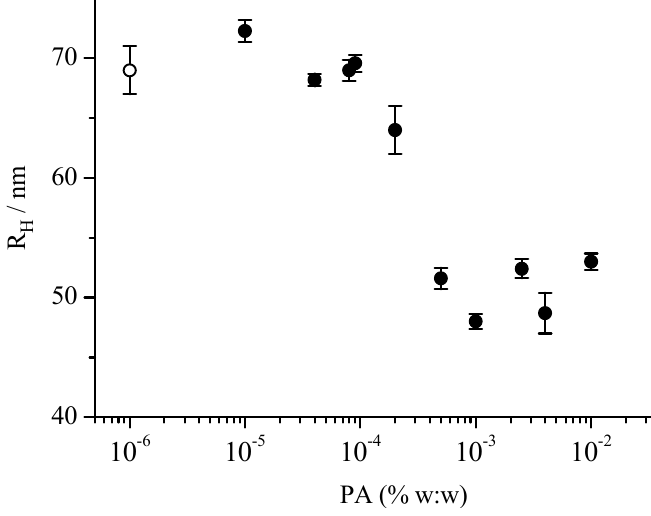
Figure 3. Changes on the apparent hydrodynamic radius values with the polymer concentration for vesicles prepared with Aerosol OT 0.03M and different PA concentration. The open circle represented on (PA) = 10 − 6 % corresponds to the hydrodynamic radius of Aerosol OT